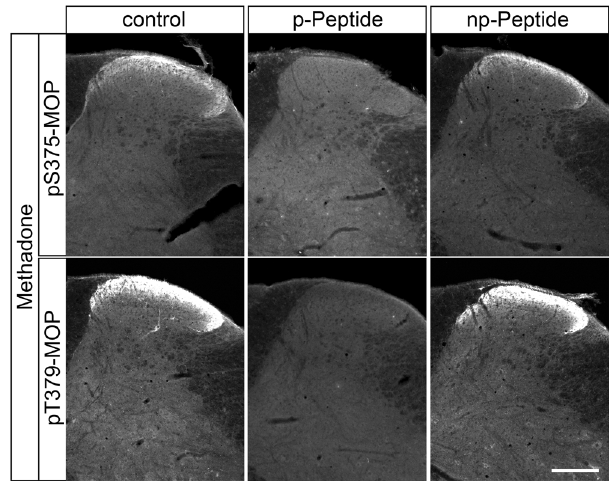
Fig. 3 Peptide neutralization of agonist-induced MOP phosphorylation staining in the mouse spinal cord. Animals were treated with methadone for 30 min, transcardially perfused, fi xed and stained in the presence of PPIs. Shown are confocal images of coronal sections of the spinal cord stained with phosphosite-speci fi c antibodies pS375-MOP or pT379-MOP in the presence or absence of their immunizing peptides containing S375 or T379 in phosphorylated form (p-Peptide) or the corresponding non- phosphorylated peptide (np-Peptide). Note that phospho-MOP immunostaining was completely neutralized by excess of phosphorylated peptide but not of non-phosphorylated peptide. Scale bar = 250 µ